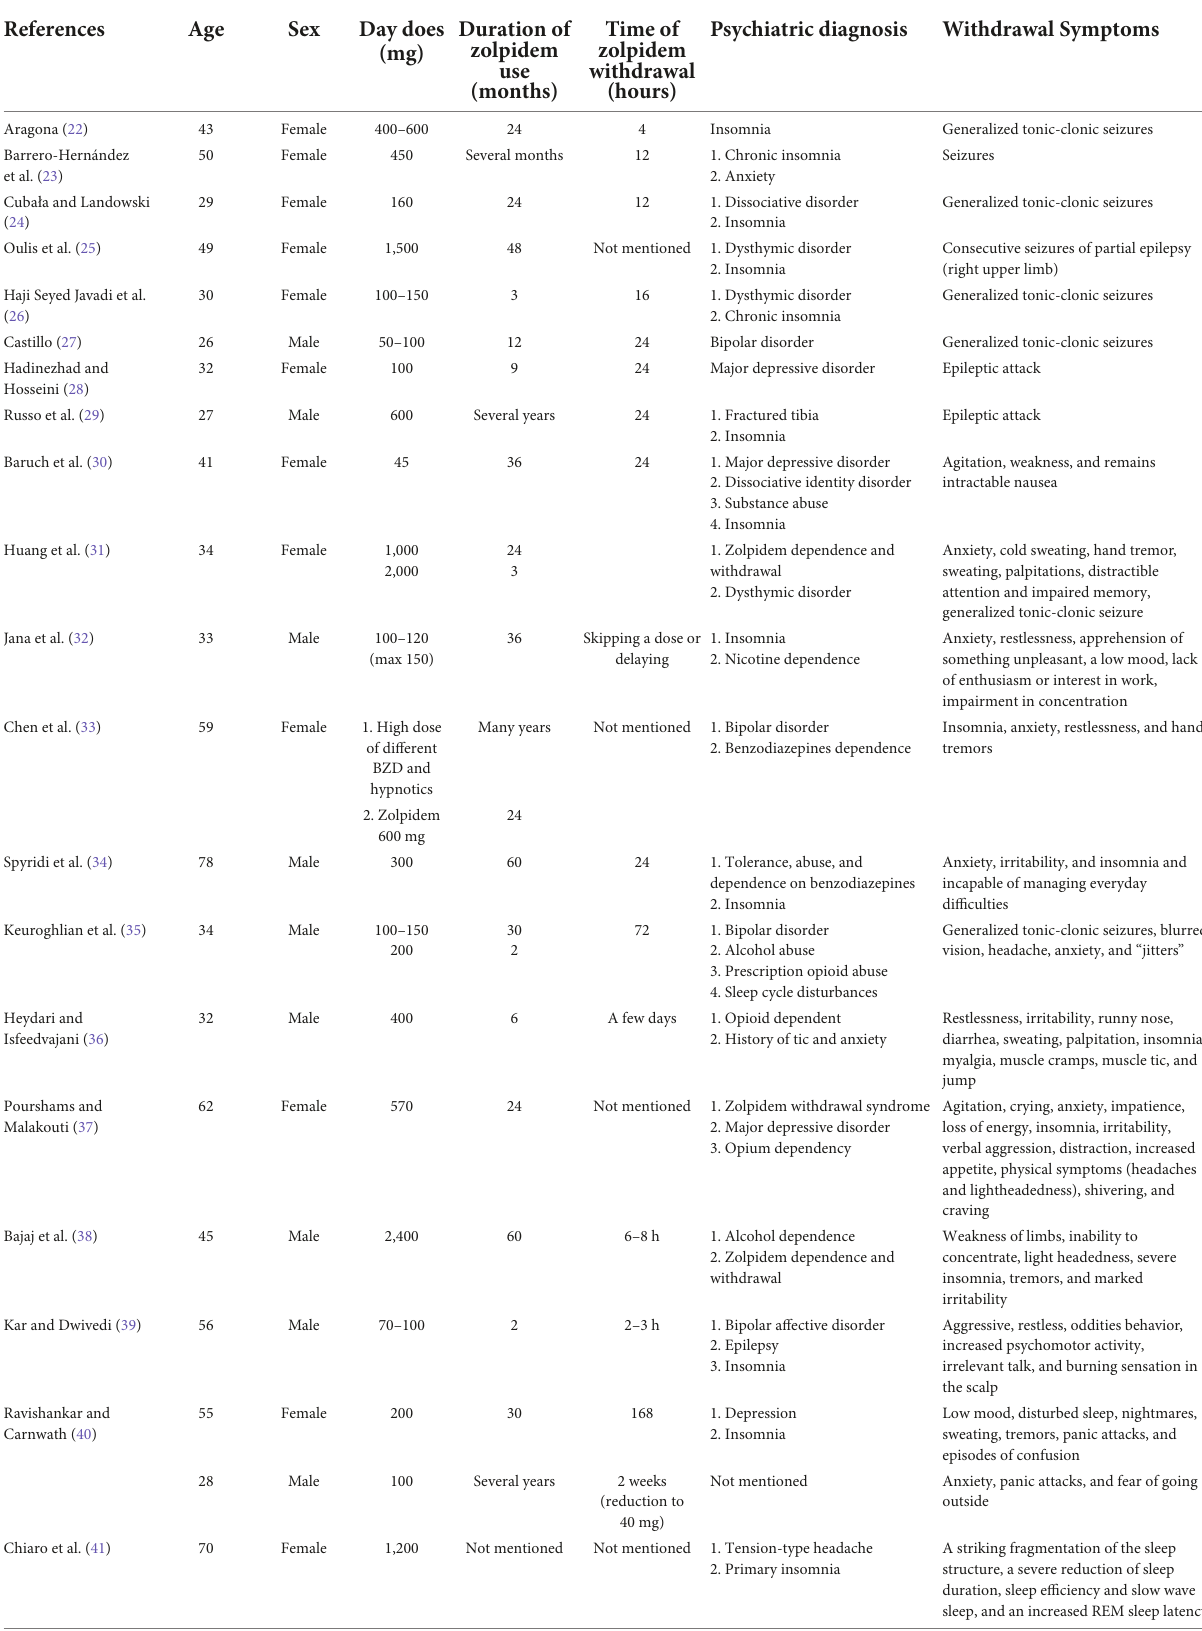
TABLE 1 Studies reviewed for withdrawal symptoms of